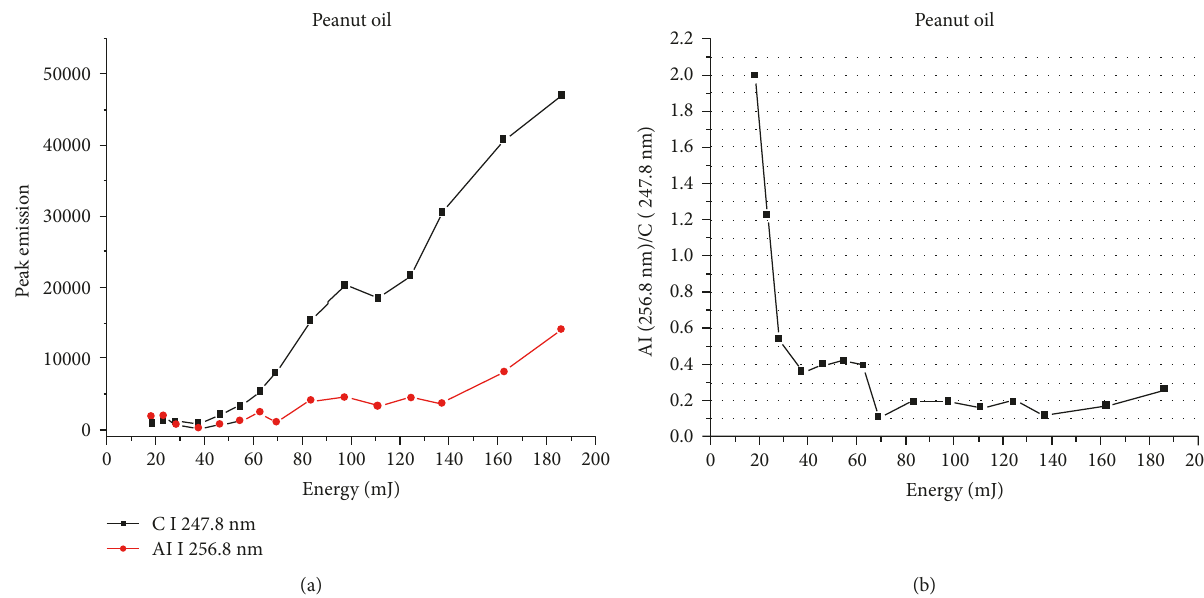
Figure 7: (a) Peak emission of C I and Al I lines averaged over 10 pulses as a function of the laser energy. (b) The corresponding line intensity ratio. The sample is peanut oil rotated at speed of 40 rpm.